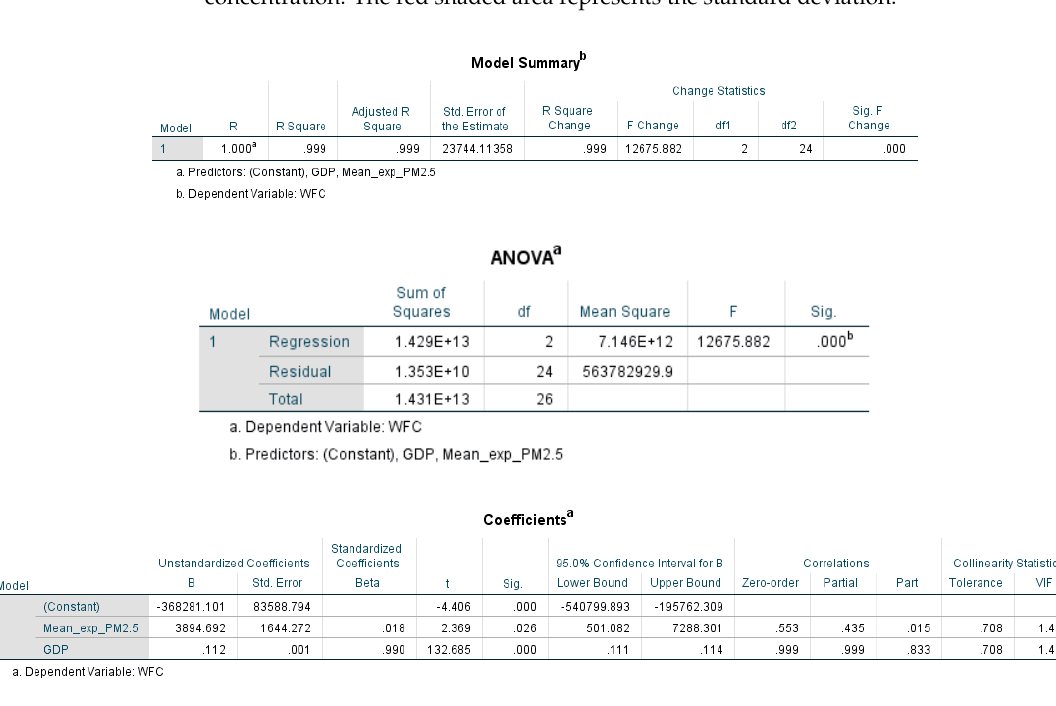
Figure A11. Cont